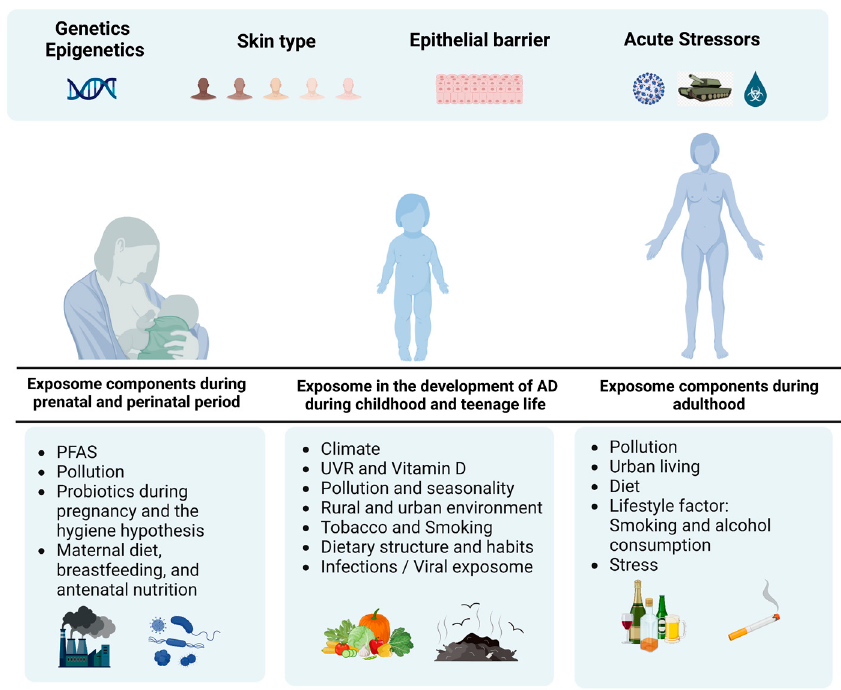
Figure 1. Exposome on the development of atopic dermatitis across the lifespan. Genetic, epige- netic, skin type and epithelial dysfunction only partially explain AD onset. The exposome including pollution, climate, rural and urban environment, lifestyle factors and acute stress differentially affects the trajectory of AD starting from conception, during pregnancy, childhood, adulthood and across the lifespan.